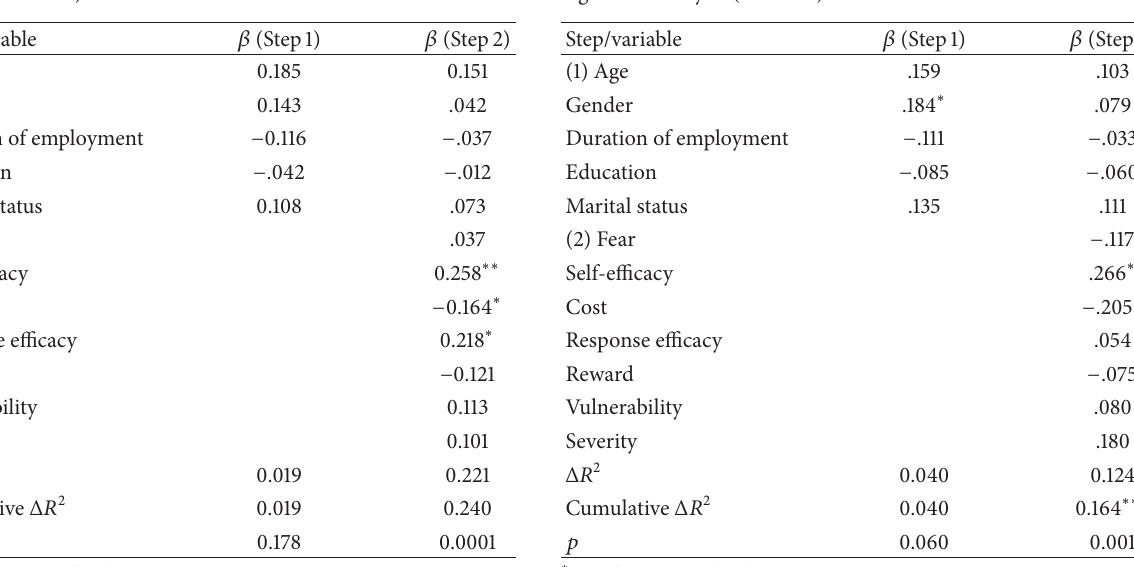
Table 6: Predicting protection motivation: hierarchical regression analysis ( 𝑁 = 161 ).